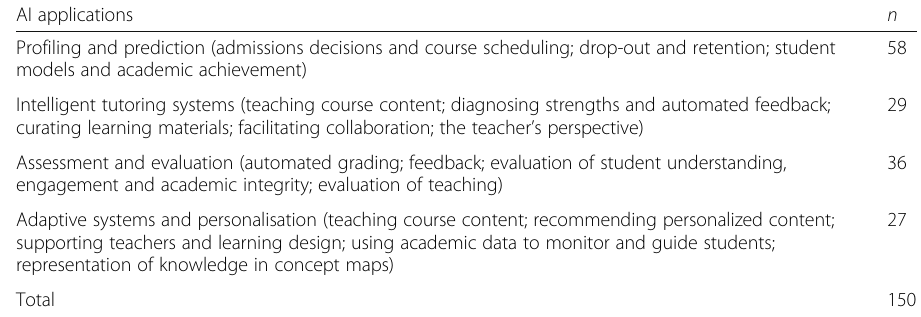
Table 6 Number of AI applications across studies ( n = 146), multiple mentions possible AI